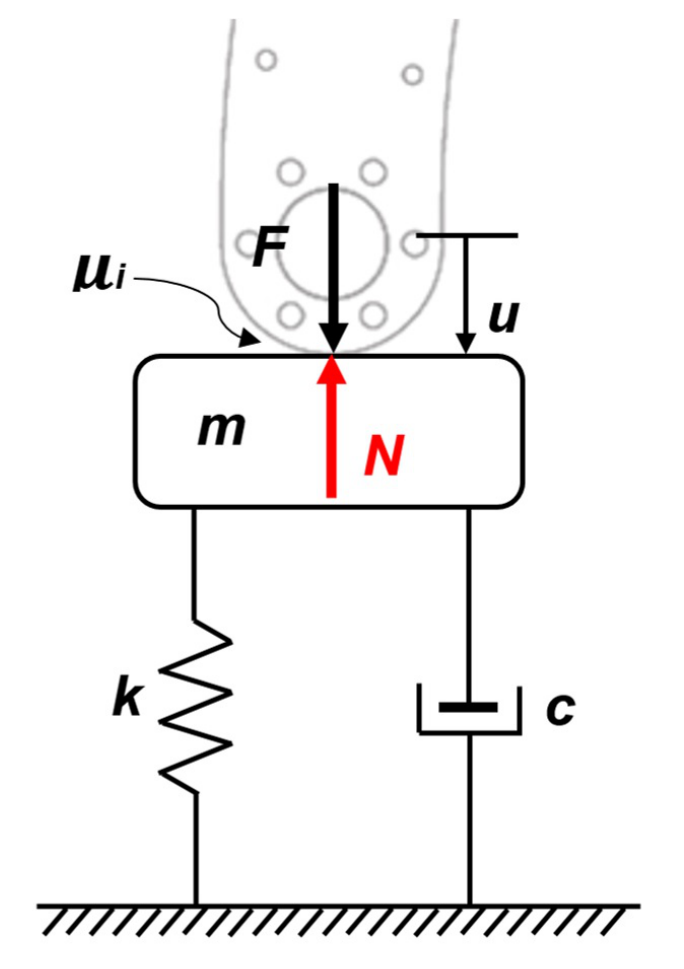
Figure 3. Equivalent mass–spring–damper–friction (M.S.D.F.) system for the seabed.